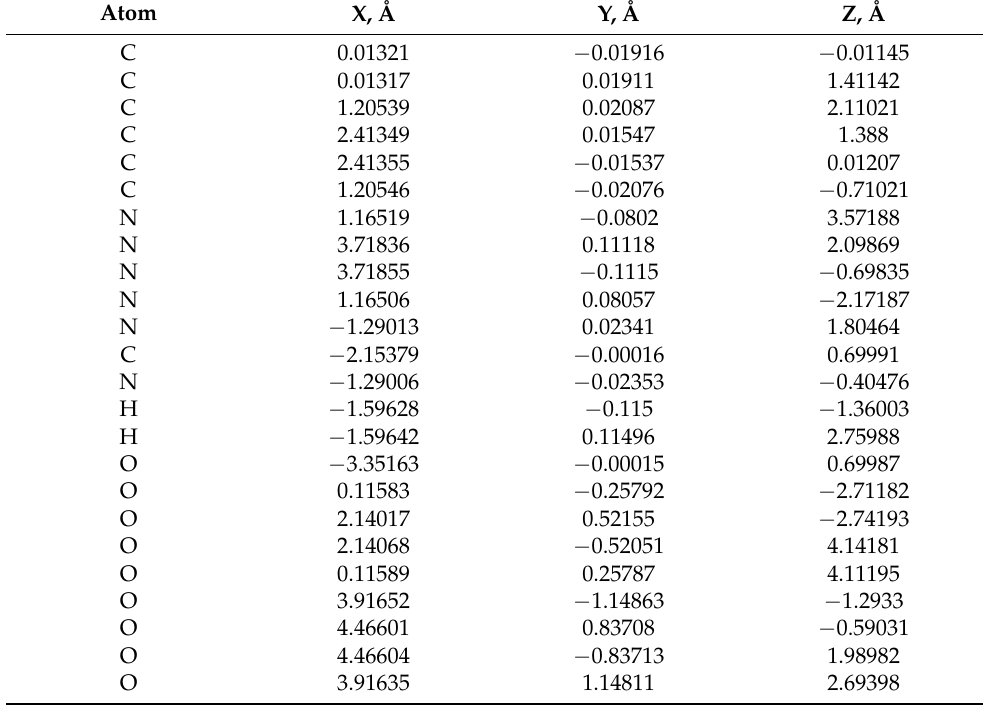
Table A1. Convergent geometries of E-I.